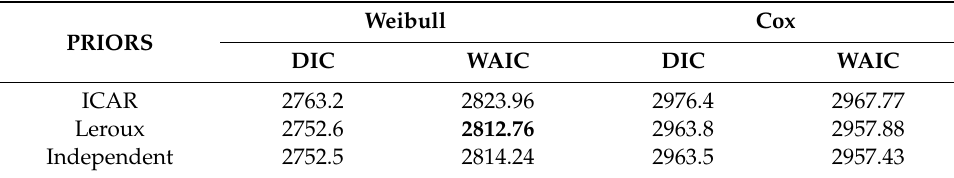
Table 5. Goodness of fit of Weibull and Cox models.